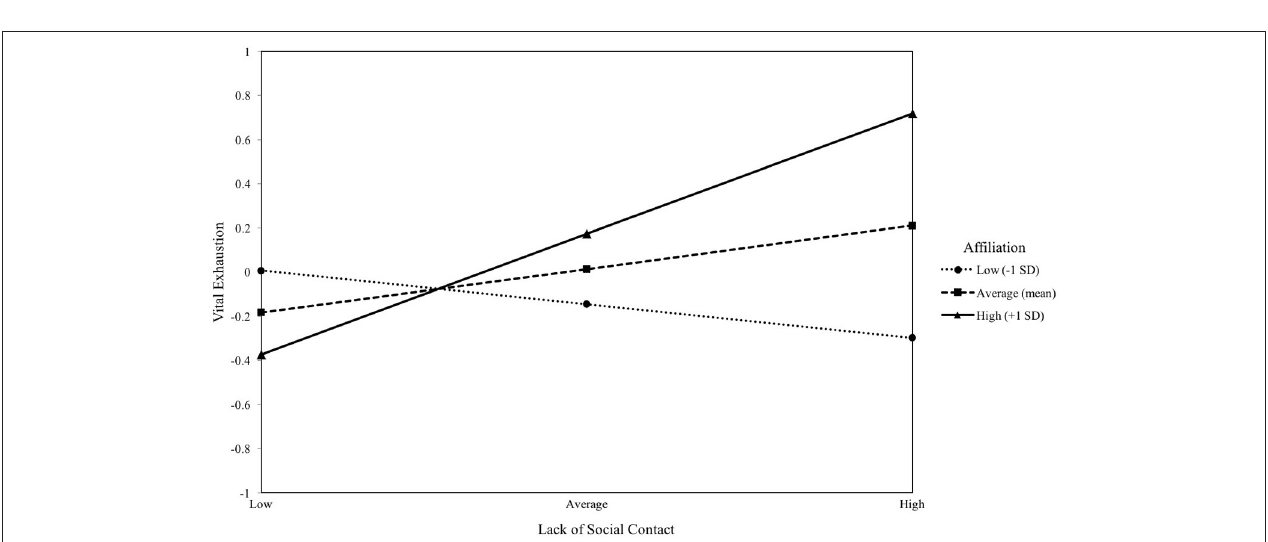
FIGURE 3 | The moderating effect of implicit affiliation motive on the association between lack of social contact and vital exhaustion. Simple slopes of lack of social contact predicting vital exhaustion for 1 SD below the mean of affiliation, at the mean of affiliation, and 1 SD above the mean of affiliation.